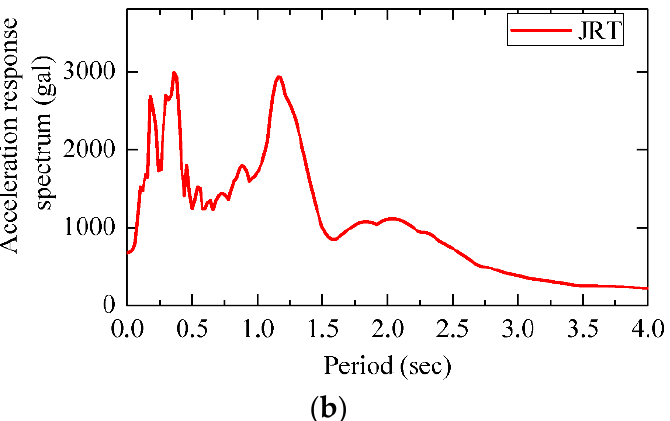
Figure 8. Acceleration response spectra ( ξ = 0.02). ( a ) Longitudinal direction. ( b ) Transverse direction.